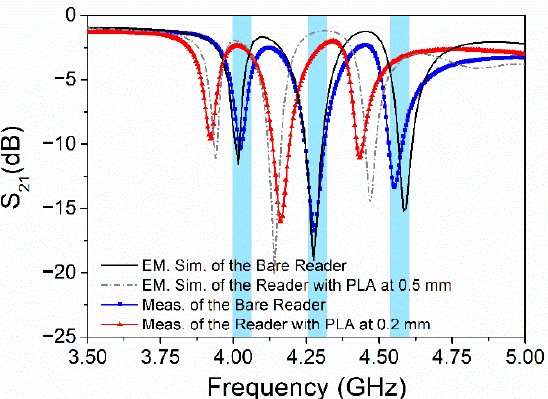
Figure 3. Electromagnetic (EM) simulation and measured frequency response of the bare reader, and the reader loaded with PLA at certain distances (air gap). The EM was obtained by means of the Keysight Momentum software.